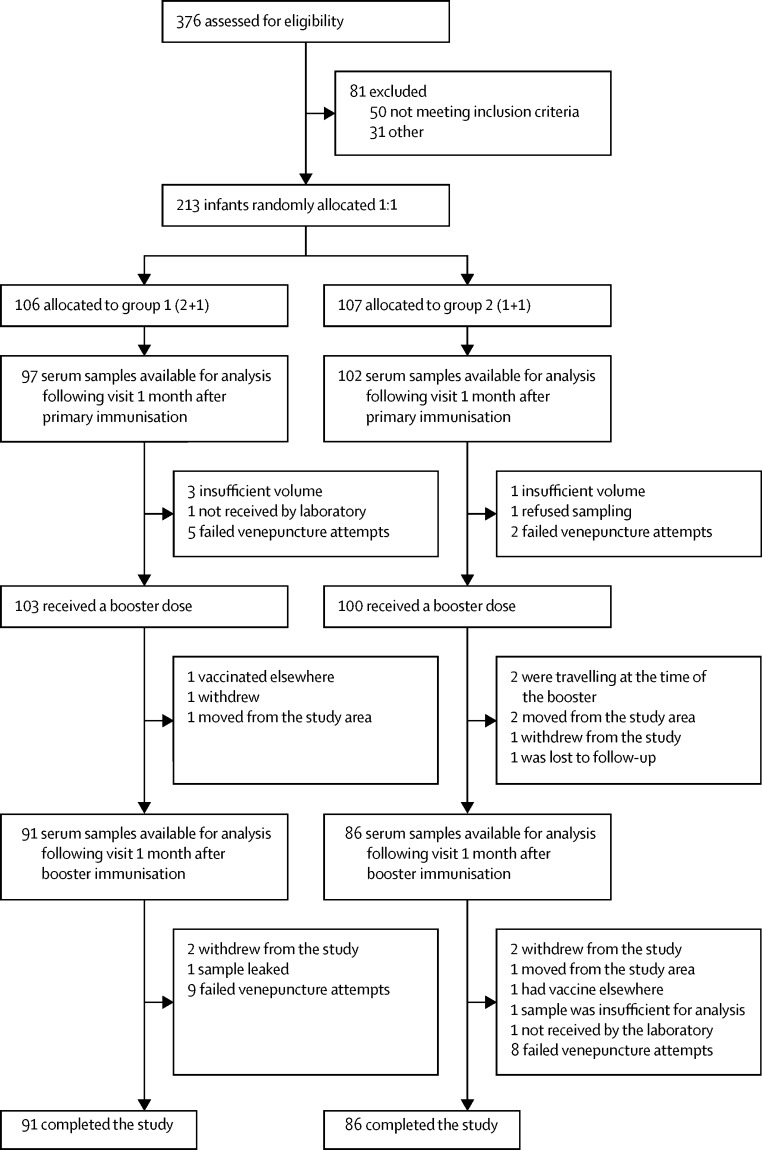
Consort details